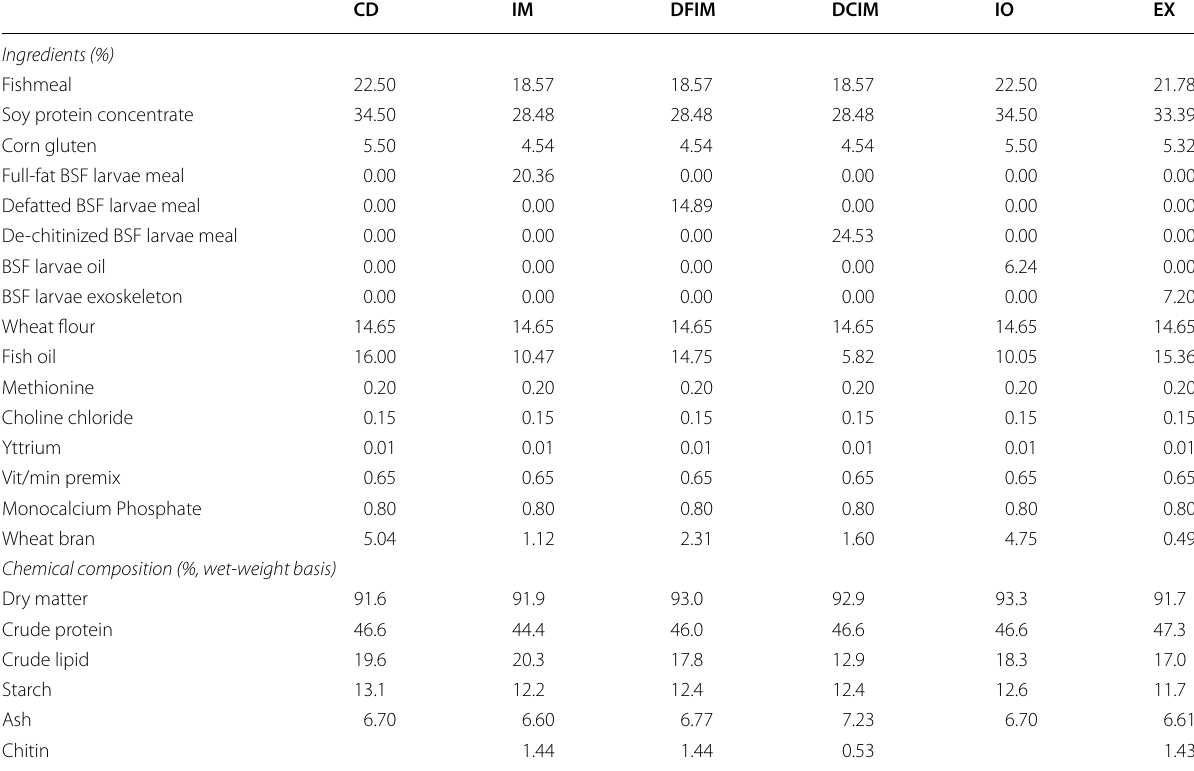
Table 1 Ingredient and chemical composition of experimental diets containing meals or fractions of black soldier fly (BSF) larvae